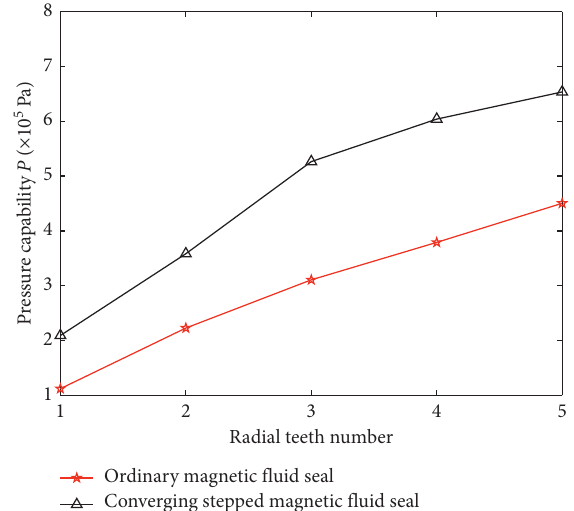
Figure 12: Pressure capability comparison between CSMS and OMS.